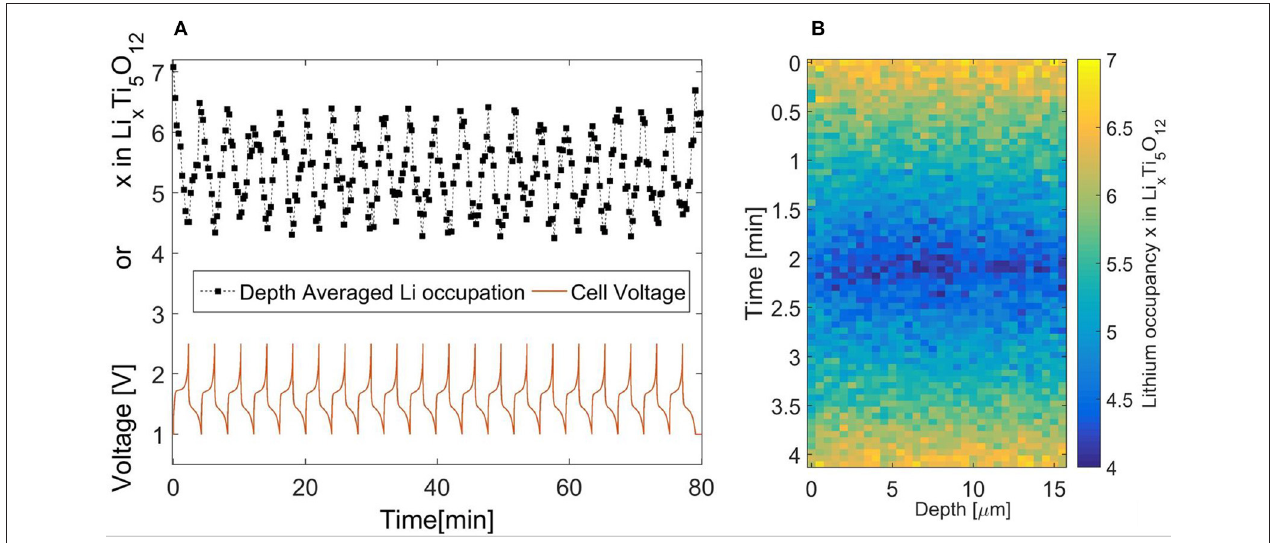
FIGURE 2 | (A) Reversible cycling of Li 4 Ti 5 O 12 during operando NDP experiments at a 30C rate. (B) Operando NDP of LTO during 30C cycling, based on accumilated data over 20 cycles. The current collector at zero depth and the electrolyte/seperator at 15 micron depth.